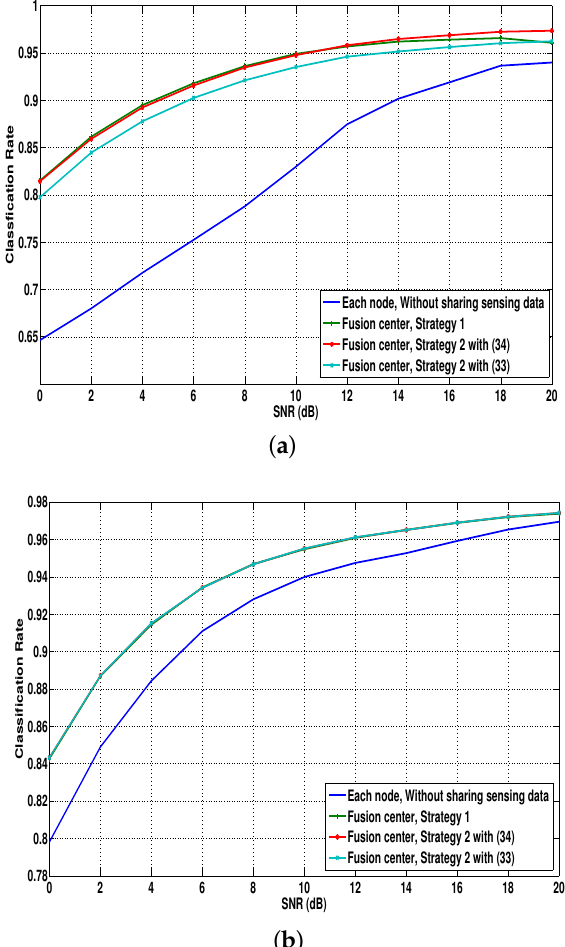
Figure 4. Average recognition rates for ( a ) [ α ( 1 ) , α ( 2 ) , α ( 3 ) ] = [ 0.14,1,1.4 ] and ( b ) [ α ( 1 ) , α ( 2 ) , α ( 3 ) ] = [ 1,1,1 ] .